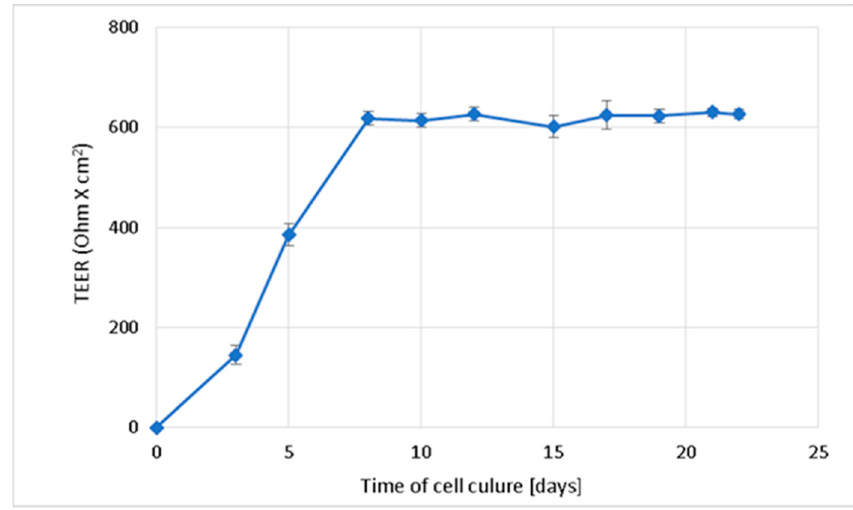
Figure 2. Change in the transepithelial electrical resistance (TEER) over time during Caco-2 cell cul- ture on membranes directed towards the formation of the integral intestinal epithelium. Results of the three independent replicates are presented as the mean ± SD.